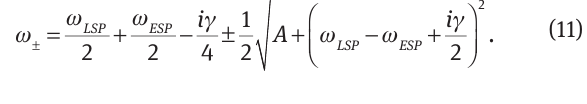
Figure 14: Schematic of two coupled oscillators each at its Eigen- frequency while only one of them is driven by an external force.